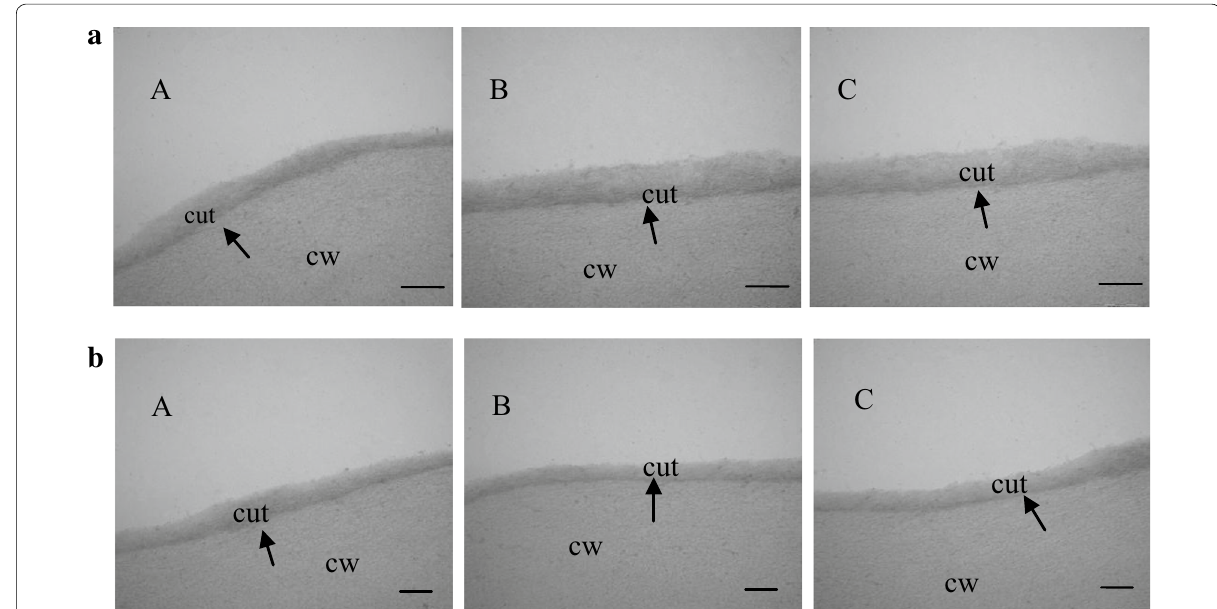
Fig. 3 Transmission electron microscopy images of epicuticular waxes. cut cuticle, cw cell wall. a Images of the stems in the Col‑0 (A), Atofp8 ‑ 1 (B) and 35S:HA ‑ AtOFP8 (C). Bars 200 nm. b Images of the leaves in the Col‑0 (A), Atofp8 ‑ 1 (B) and 35S:HA ‑ AtOFP8 (C). Bars =